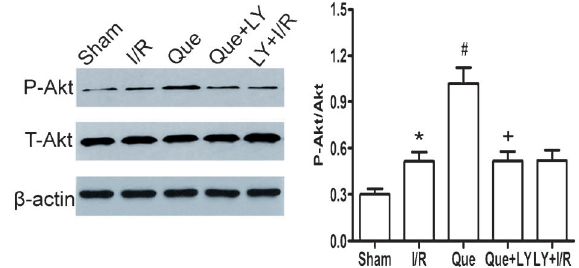
Figure 5. Effect of Que postconditioning on P-Akt expression during myocardial I/R (n=5). Data are reported as means±SD. Que: quercetin; I/R: ischemia/reperfusion; LY: LY294002; P-Akt: phospho-Akt; T-Akt: total-Akt. *P , 0.05 vs sham group, # P , 0.05 vs I/R group, + P , 0.05 vs Que group (one-way ANOVA followed by the Bonferroni